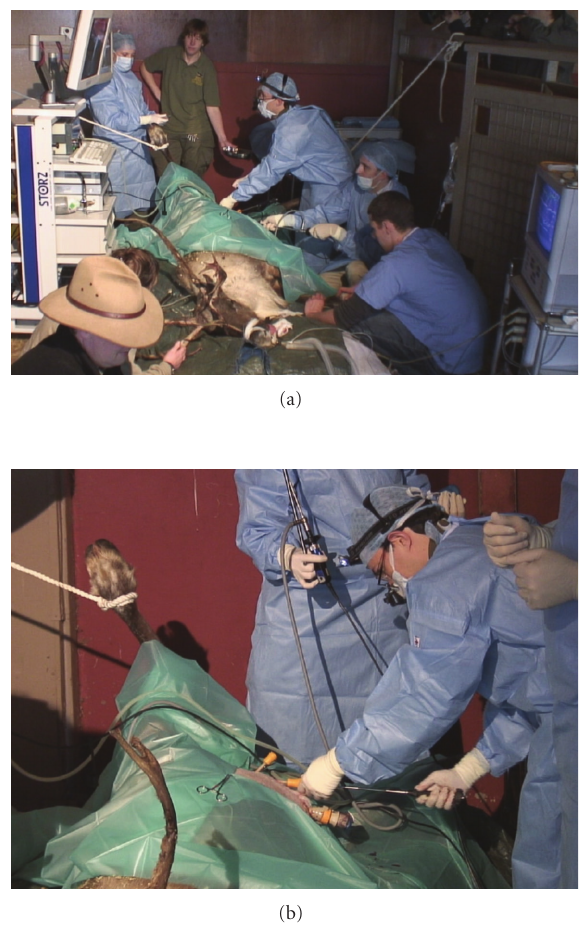
Figure 2: (a) Positioning of the reindeer in dorsolateral oblique recumbency. (b) Open approach midline subumbilical placement of the primary optical port and 5 mm instrument ports in left caudal